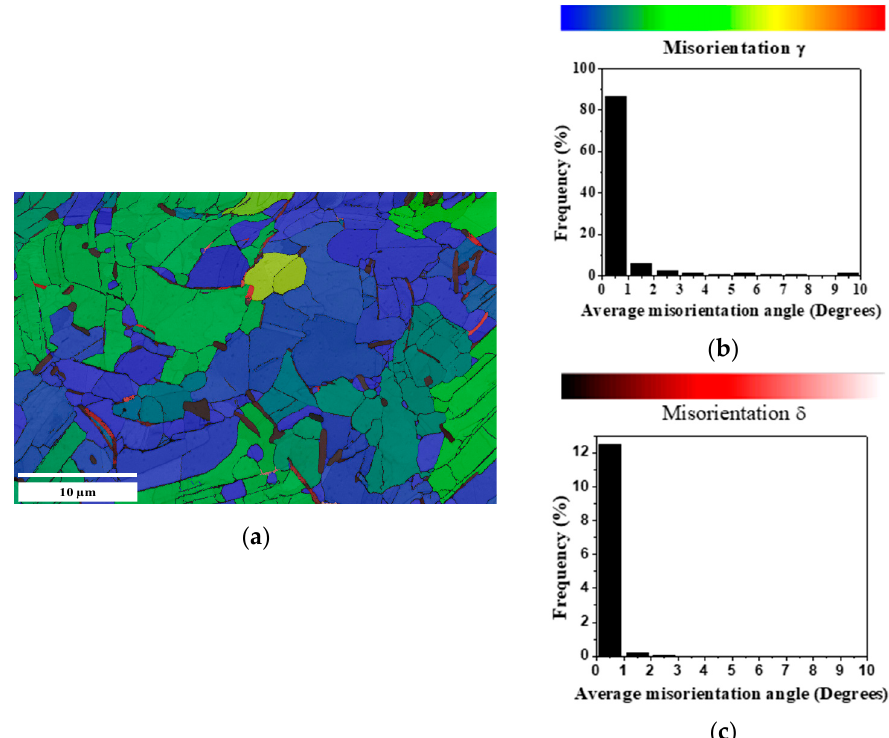
Figure 11. Sample B. OIM: ( a ) misorientation relationship ( γ < 1° in blue, δ < 1° in red tones) phase limit; ( b ) γ “frequency vs. average disorientation”; ( c ) δ “frequency vs. average disorientation”.